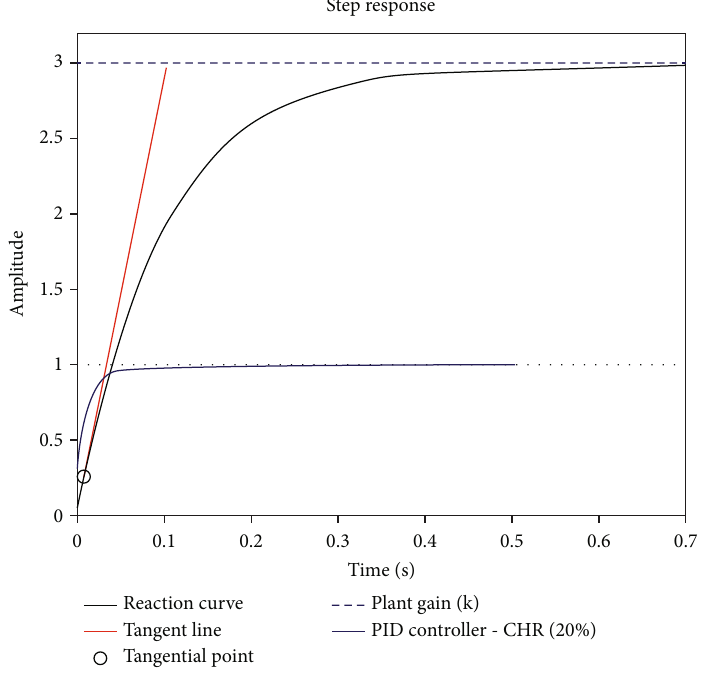
Figure 17: Reaction curve or a